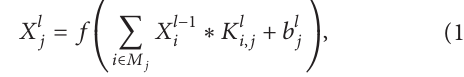
(Figure 1): the input layer I, the convolution layer C, the sampling layer S, the output layer O, and sometimes the full- connection layer